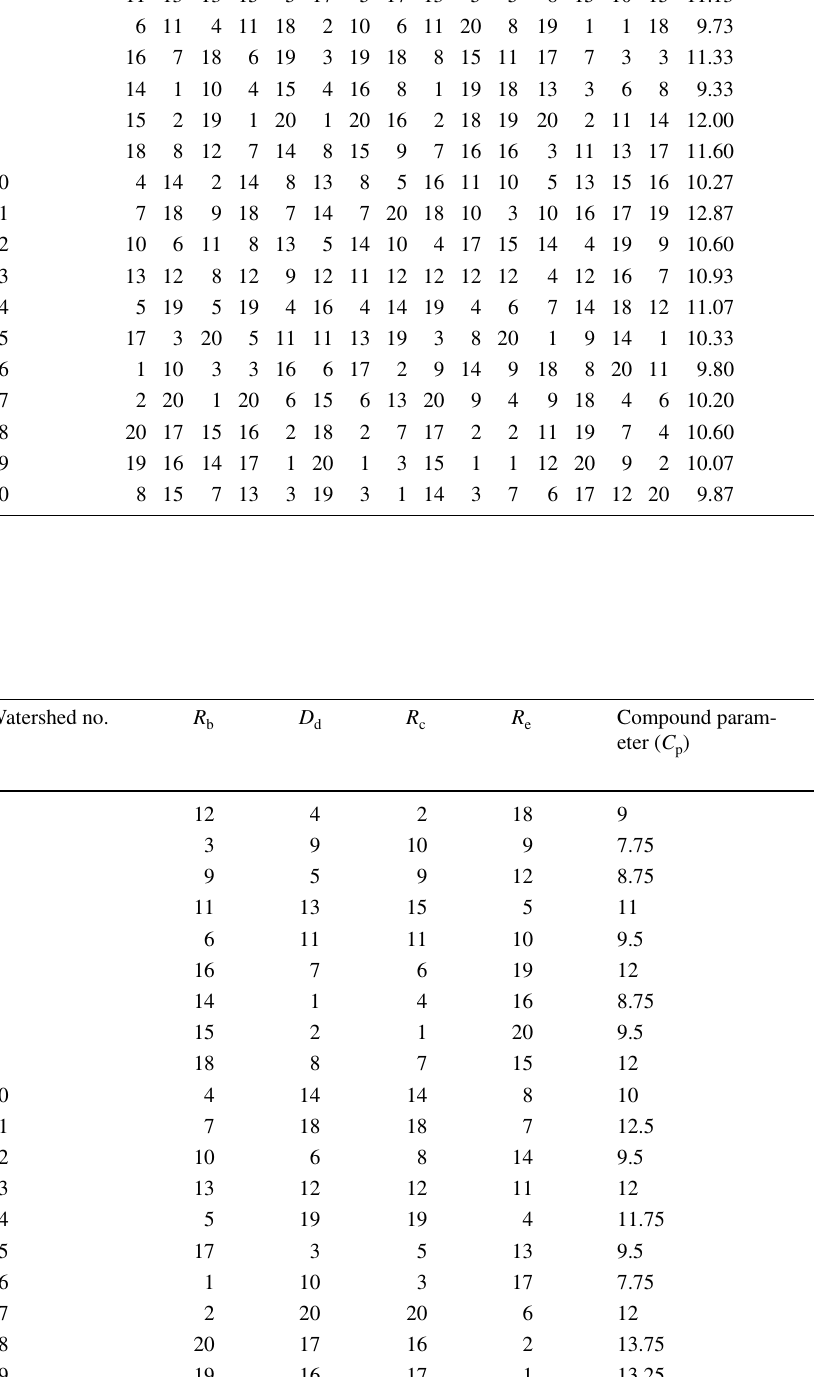
watersheds and theirs ranks